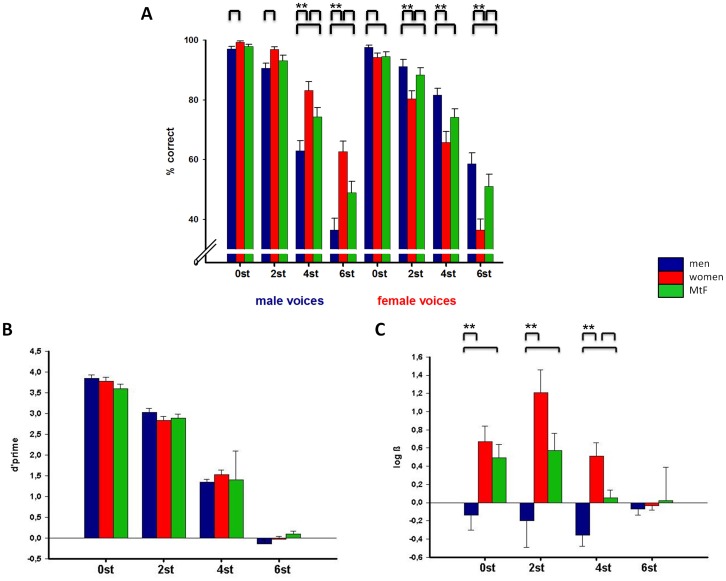
Behavioral performance.A. Performance (% hits with standard error bars) in response to male (left) and female (right) voices of the different morphing steps in semitones (st) in men (blue), women (red) and MtFs (green). Significant differences between groups are marked by bars (p<0.05) or asterisks (p≤0.002 Bonferroni corrected). B. Gender discrimination sensitivity (d-prime with standard error bars). C. Response bias (log ß with standard error bars) for each morphing step in men, women and MtFs with positive values representing bias to choose male voices and negative values representing bias to choose female voices. Significant differences are marked by bars (p<0.05) or asterisks (p≤0.002 Bonferroni corrected).